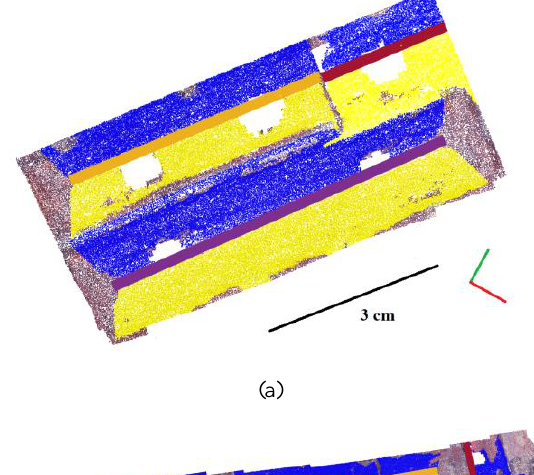
Figure 7. Extraction of chimneys (one colour per chimney): (a) block 5 – 5 chimneys extracted; (b) block 6 – 32 chimneys extracted 3.3.3